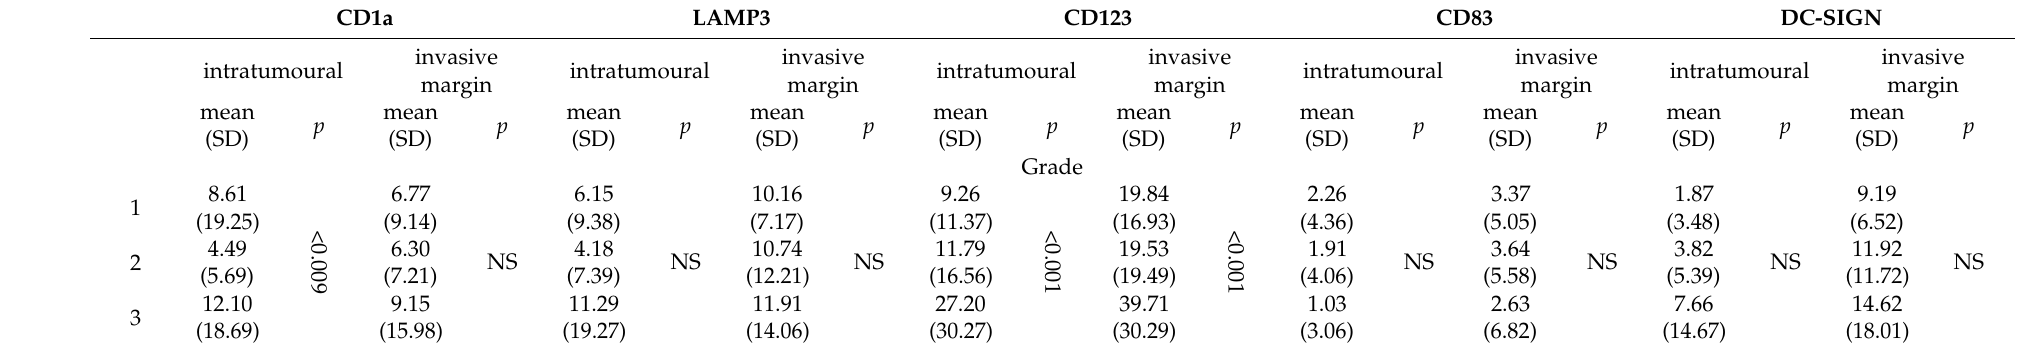
Table 5. DC count according to tumour grade.